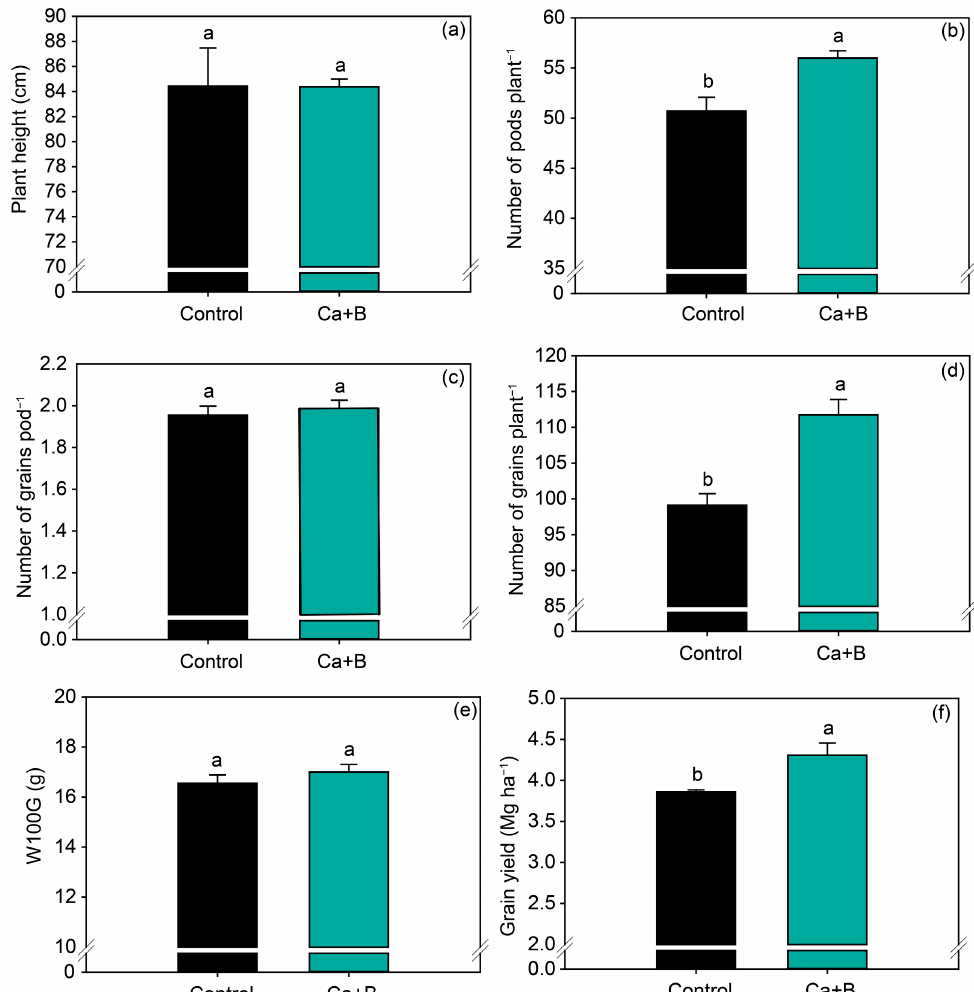
Figure 5. Production components: plant height ( a ), number of pods per plant ( b ), number of grains per pod ( c ), number of grains per plant ( d ), weight of 100 grains (W100G) ( e ) and grain yield ( f ) as a function of foliar application of calcium (Ca) plus boron (B). Different lowercase letters indicate a significant difference between Ca + B treatments by Fisher’s test ( p ≤ 0.05). Error bars express the standard error of the mean ( n =